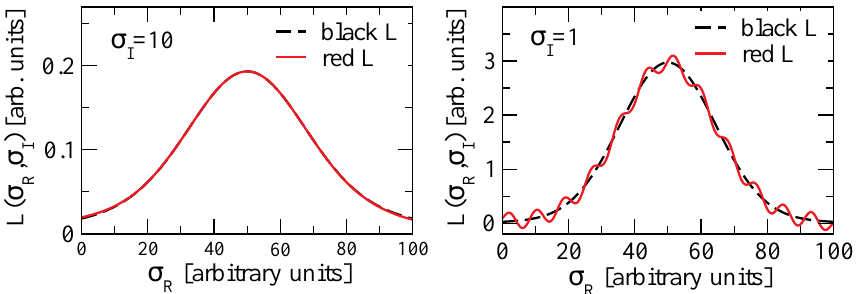
Figure 2: The LITs of black (black dashed) and red responses (red solid). Left panel: σ = 10 units. Right panel: σ I